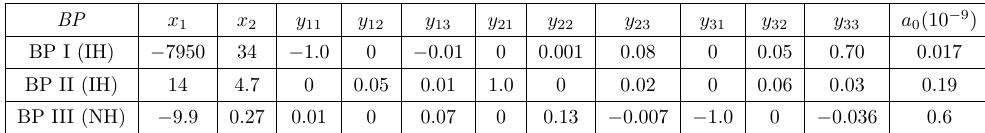
Table 10 . Values of parameters chosen for di(cid:11)erent sets of Yukawa structure given in eqs. (4.87){ (4.89) to (cid:12)t the neutrino oscillation data.